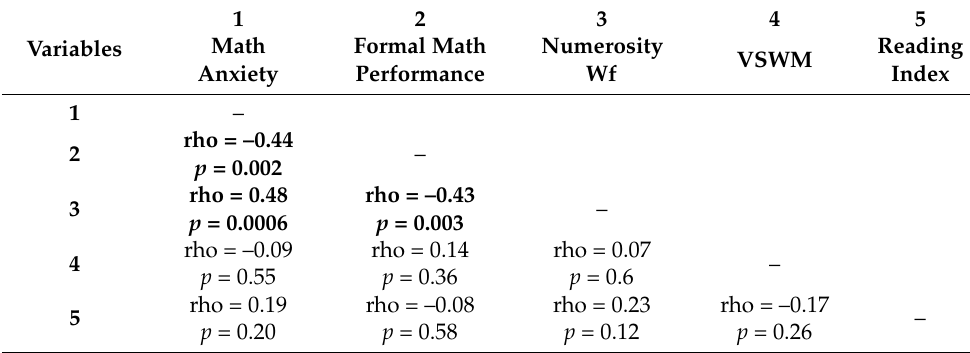
Table 2. Correlational matrix. Spearman’s correlations and p -values between the various measures. Variables